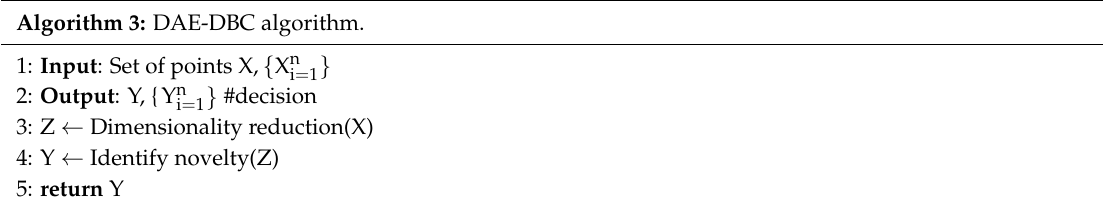
Algorithm 3: DAE-DBC algorithm.